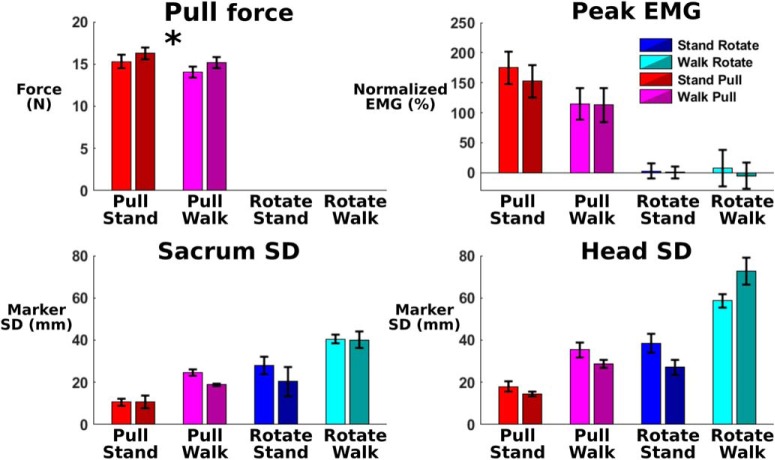
The average and SE of the first (lighter color) and last (darker color) minute of each 10 min trial are shown for behavioral measures (n = 30). Because the pull force could be calculated only during the pull perturbation, there are no values during the rotation perturbations. We only found a significant difference between the first and last minute for pull force (denoted by asterisk; repeated-measures ANOVA, p = 0.031), although no pairwise comparisons were significant. We found no other significant adaptation effects for the other measures. Our results indicate that minimal adaptation effects were present.